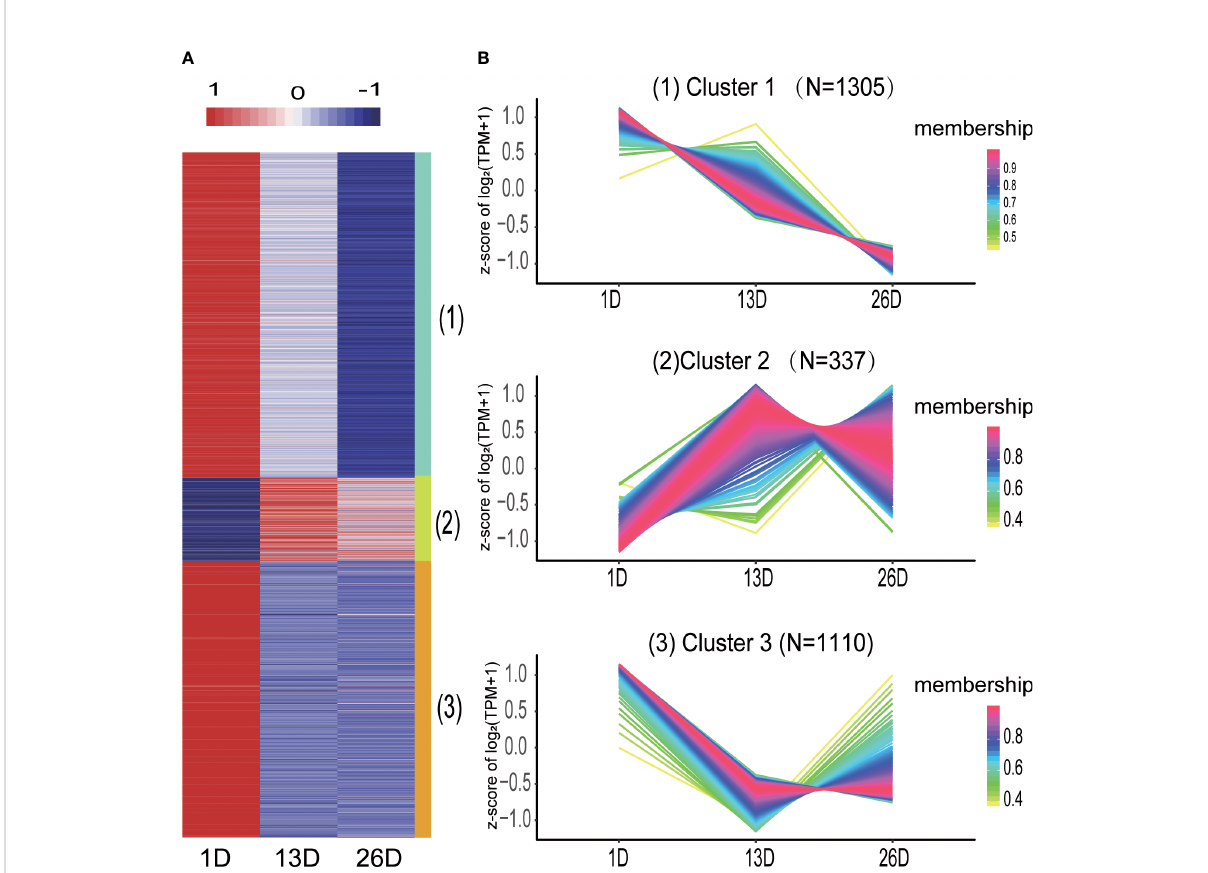
FIGURE 4 Distinct expression patterns of differentially expressed mRNAs across the BF development stages. (A) . The heatmap shows the expression patterns of the three clusters. Each row represents a mRNA. The color indicates the Z-score of normalized expression values. (B) . Cluster analysis of the DE mRNA expression patterns across the BF development stages. Membership values indicate the goodness of fi t for mRNAs in a particular